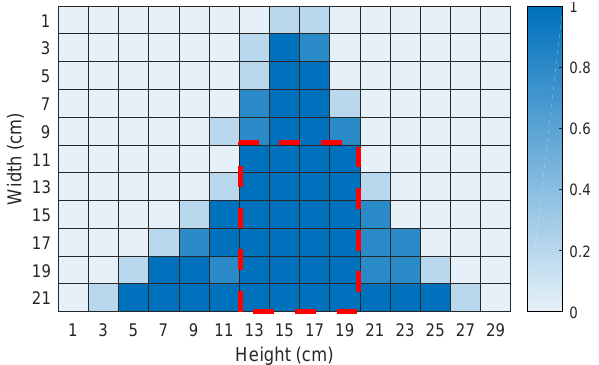
Figure 7. Acoustic sensing